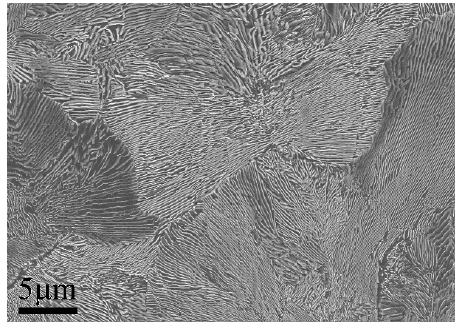
Figure 3. SEM micrographs of initial pearlitic wires.